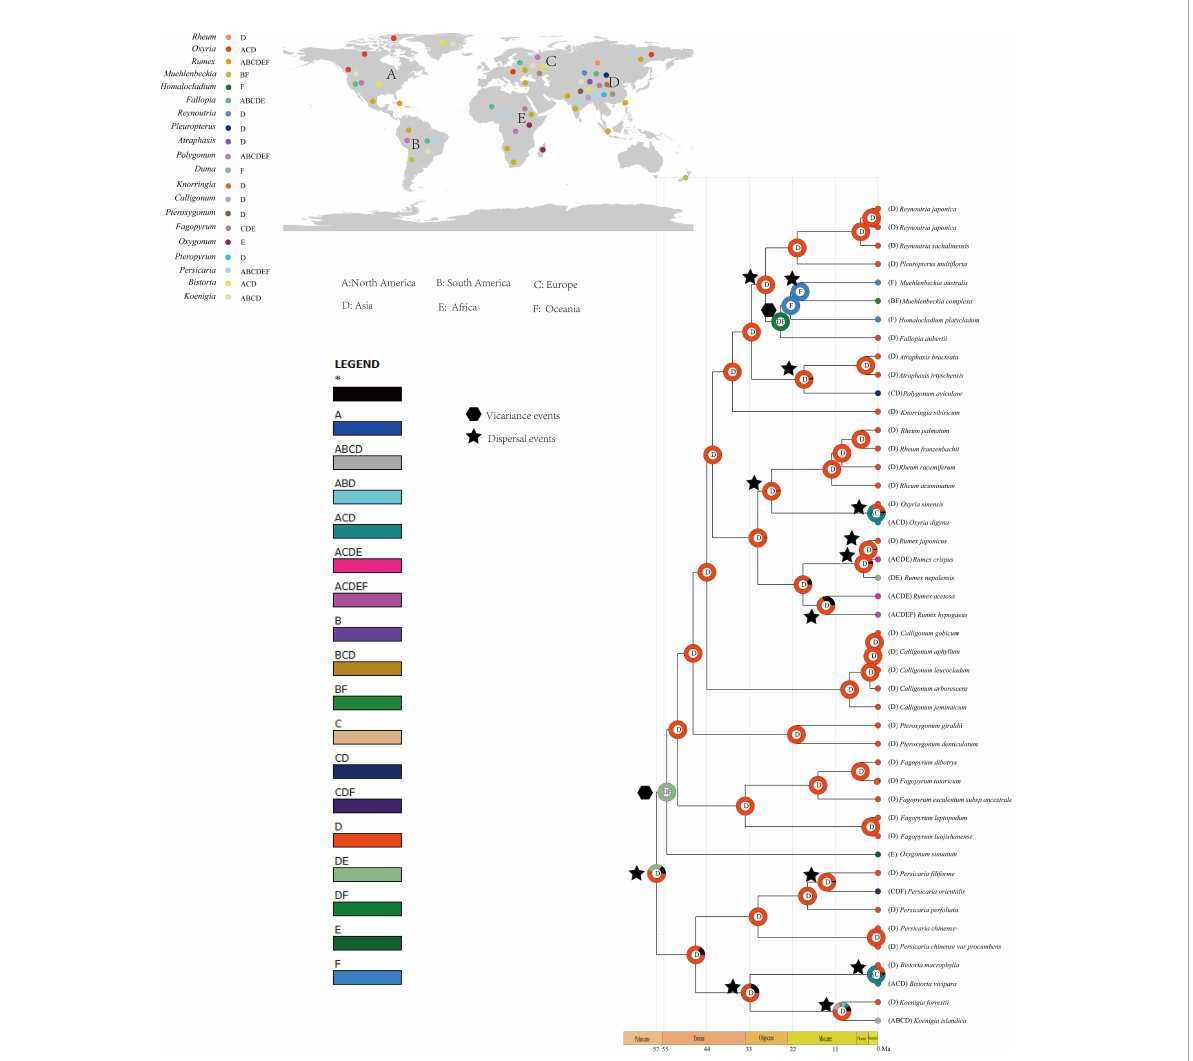
FIGURE 5 Ancestral area reconstruction of Polygonaceae. Figure of upper left shows the distribution of each